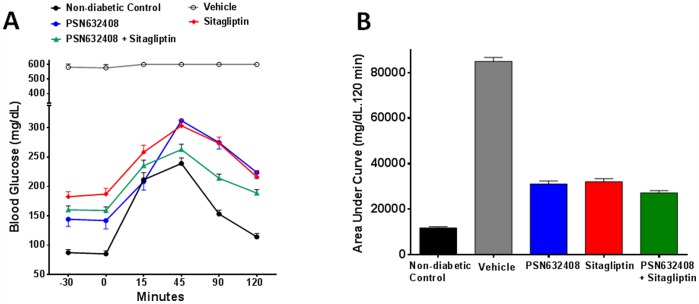
(A) OGTT in non-diabetic control mice and diabetic mice treated with vehicle, and those that achieved normoglycemia after 7 weeks treatment with PSN632408, sitagliptin, or PSN632408 and sitagliptin combination (n = 5 mice per group).Blood glucose levels in mice treated with PSN632408 and sitagliptin combination were significantly lower than in mice treated with PSN632408 alone at 45 minutes and at 90 minutes (p<0.01) and in mice treated with sitagliptin alone at 90 minutes (p<0.01). (B) Blood glucose AUC0–120 in mice treated with PSN632408, sitagliptin, or PSN632408 and sitagliptin combination was significantly lower than in mice treated with vehicle (P<0.01).